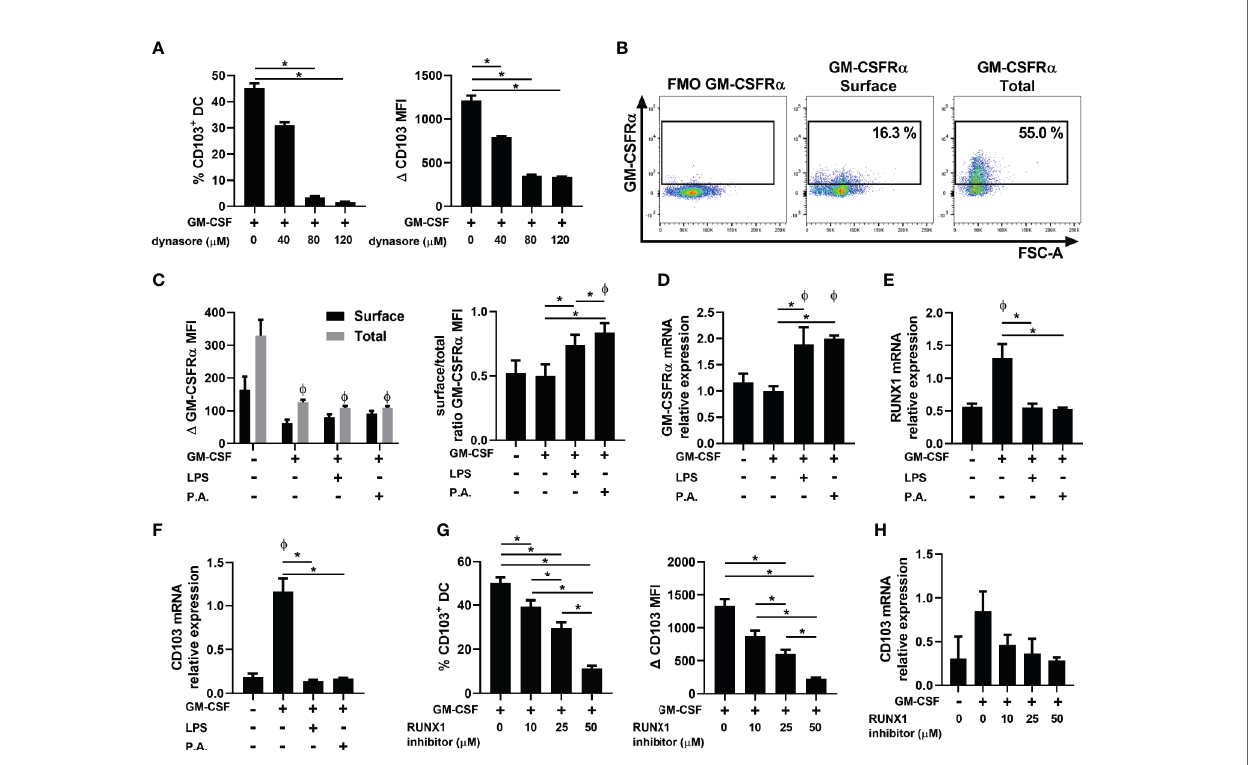
FIGURE 4 | P. aeruginosa in fl uences GM-CSFR localization on BMDCs. FLT3L – BMDCs were stimulated for (A – G) 48 h or (B – F, H) 12 h with GM-CSF ± (A) Dynasore, (B – F) GM-CSF ± LPS or P. aeruginosa (P.A.) or (G, H) a RUNX1 inhibitor. (A – G) Percentage of CD103 + and D CD103 MFI on cDCs. (B) Representative fl ow cytometry pro fi le of surface and total GM – CSFR a expression on FLT3L-BMDCs. (C) Surface (extracellular) and total (extracellular + intracellular) D MFI ( fi rst panel) of GM-CSFR a , and ratio of surface to total expression of GM-CSFR a (second panel). (D) mRNA relative expression of GM-CSFR a ( Csf2ra ). (E) mRNA relative expression of RUNX1. (F, H) mRNA relative expression of CD103 ( Itgae ). Data are presented as mean ± SEM; (A) n = 3 representative of two separate experiments. (C – H) n = 4-6 samples of cDCs per group pooled from two separate experiments. *p < 0.05 compared between conditions stimulated with GM – CSF. F = p < 0.05 compared to unstimulated condition. P-values were analyzed using paired-one-way and two-way